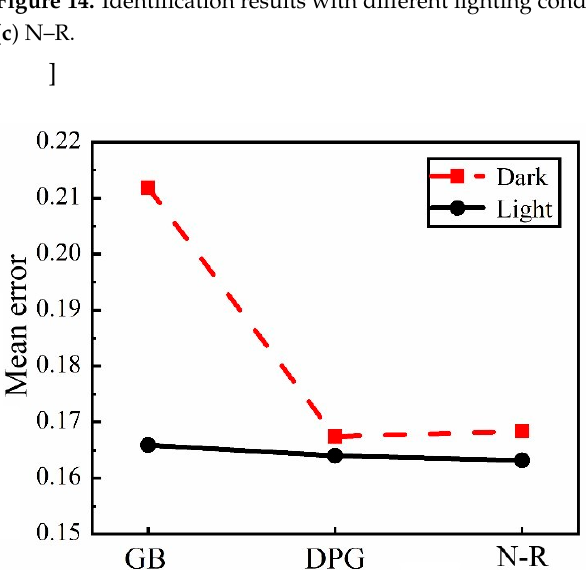
Figure 15. Mean error of recognition results under different algorithms.